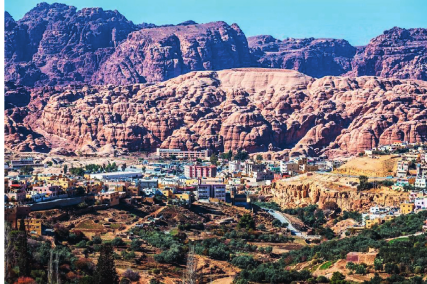
Figure 2: Aerial view of Wadi Musa town.